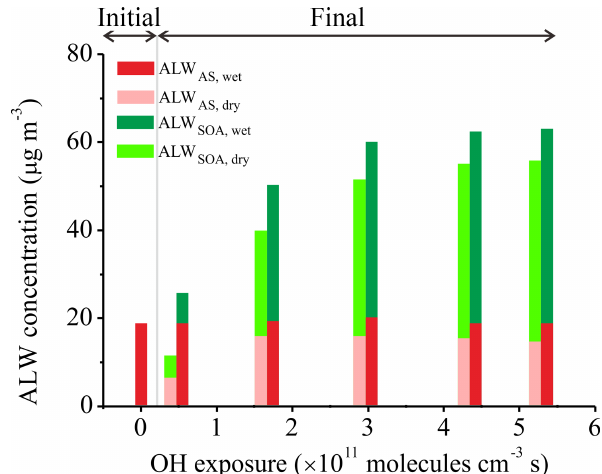
Figure 3. Mass concentration of ALW uptake by AS and toluene- derived SOA before (initial) and after reactions (final) for both ini- tially wet and dry AS seeds. Adjoining bars for initially wet and dry seeds have same OH